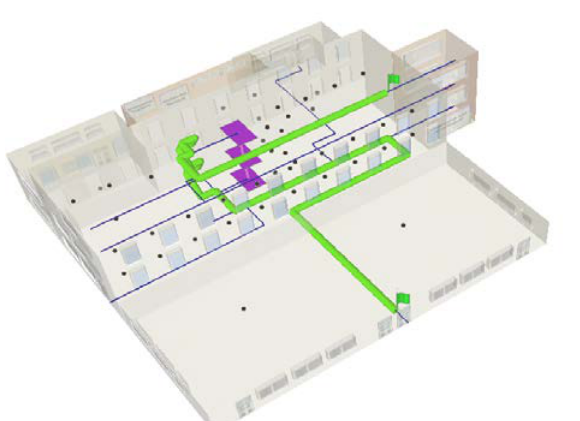
Figure 11. Viewing exterior shell and routes simultaneously